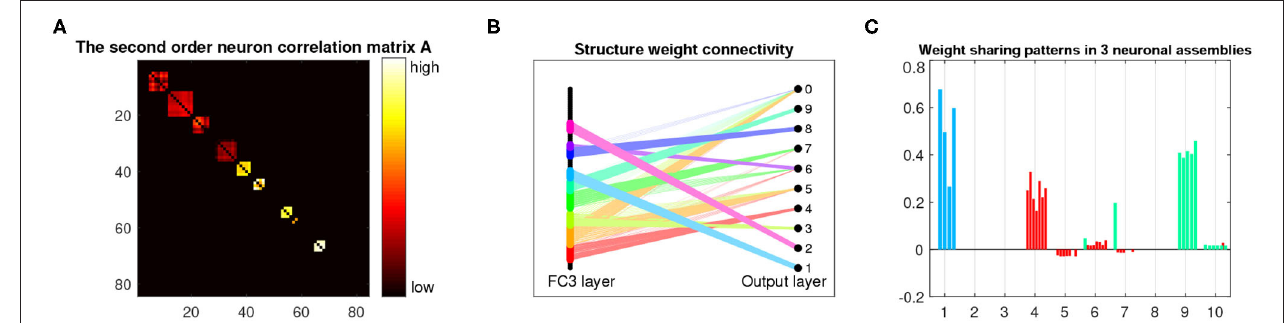
FIGURE 6 | Analysis and visualization of the last dense layer of LeNet-5 + BEAN-2 model on the MNIST 10-shot learning from scratch task. (A) Heat-map of the learned second-order neuron correlation matrix: neuron indices are re-ordered for best visualization of neuronal assembly patterns; BEAN is able to enforce plausible assembly patterns that act as functional clusters for the categorical learning task. (B) Visualization of the parsimonious connectivity learned in the dense layer: both neuron-level and weight-level sparsity are simultaneously promoted in the network after applying BEAN regularization. The neurons are grouped and colored by neuronal assemblies. (C) Visualization of the scales of neurons’ outgoing weights: the weights of the neurons are colored to be consistent with the neuron group in (B) .